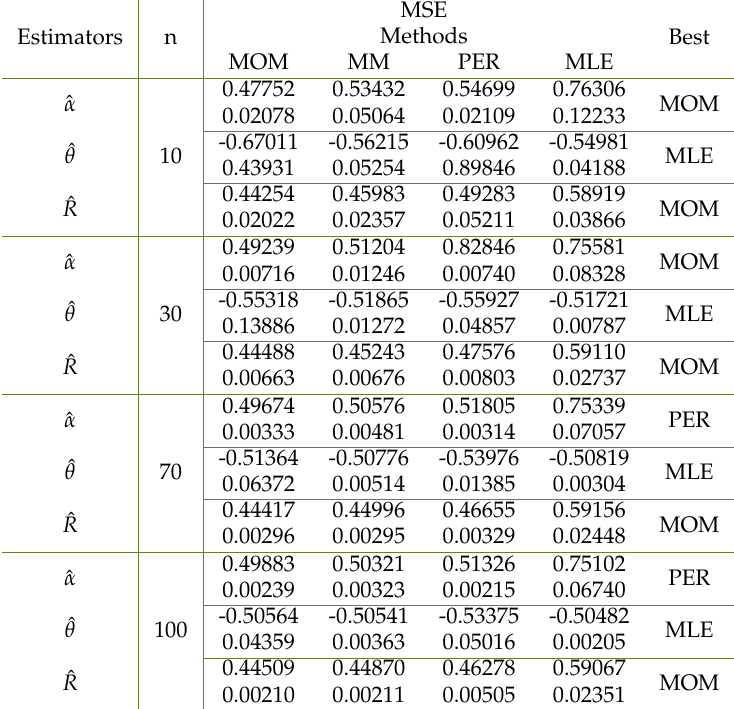
Table 2. Estimated values for ( α , θ ) and ( R ) using ( E 1 : R = 0.44732)